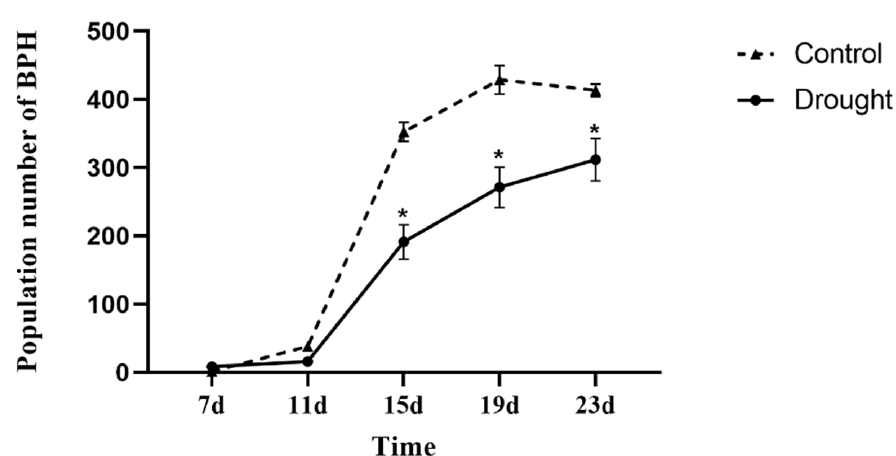
Figure 1. Population changes in BPH fed on drought-stressed and non-stressed (control) rice plants for 7, 11, 15, 19, and 23 days. Data are expressed as means ± SE. * represents significant differences between drought-stressed and control treatments ( PLSD test, p < 0.05).